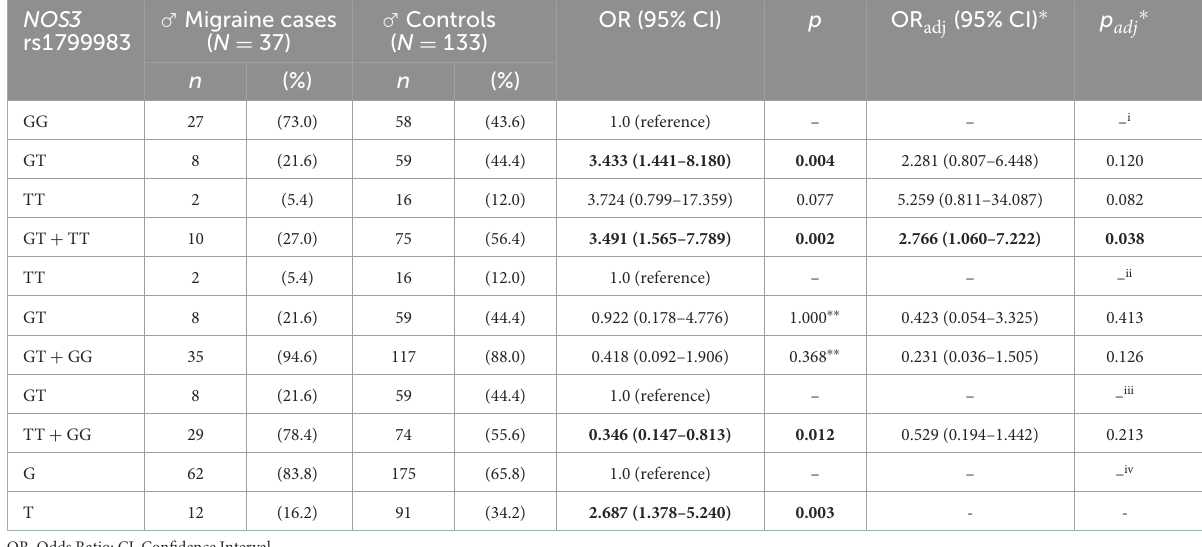
TABLE 3 Genotypic and allelic frequency distribution analysis of the NOS3 rs1799983 variant in male subjects. NOS3 rs1799983